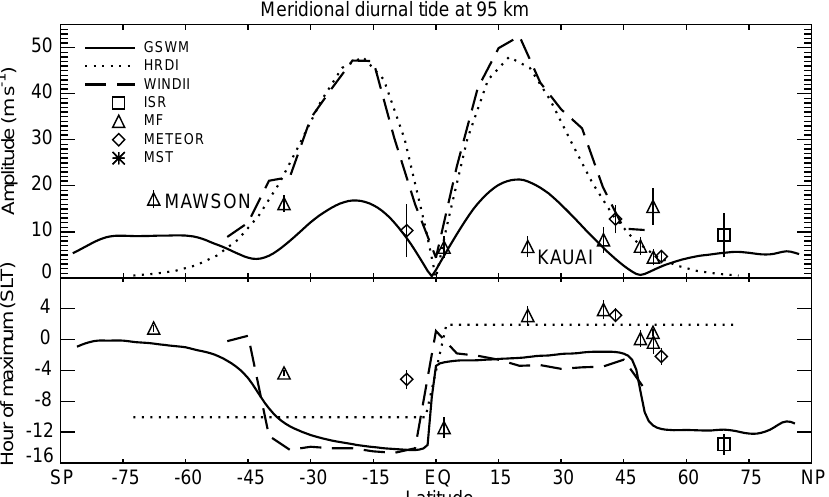
Fig. 12. Same as Fig. 6 except for the meridional